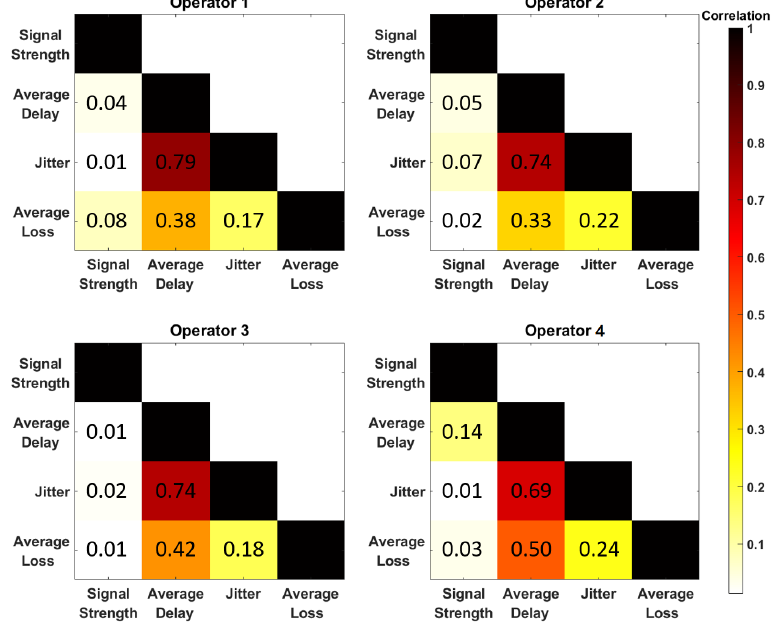
Figure 1. Correlation Heat-Map between QoS Metric. The “Delay-Jitter” set of parameters has the highest correlation (dark red), followed by the “Delay-Packet Loss” and “Jitter-Packet Loss” combinations. The correlation between Delay and Jitter ranges from 69% to 79%, which is logical given that Jitter is the variability in delay between